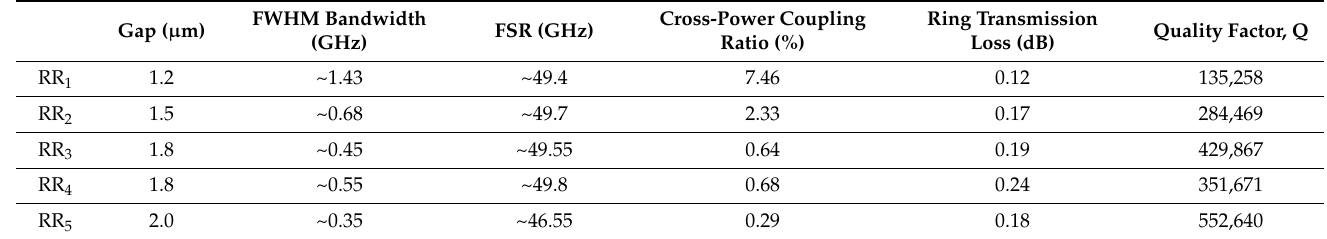
Table 1. Measured and extracted parameters of fabricated ring